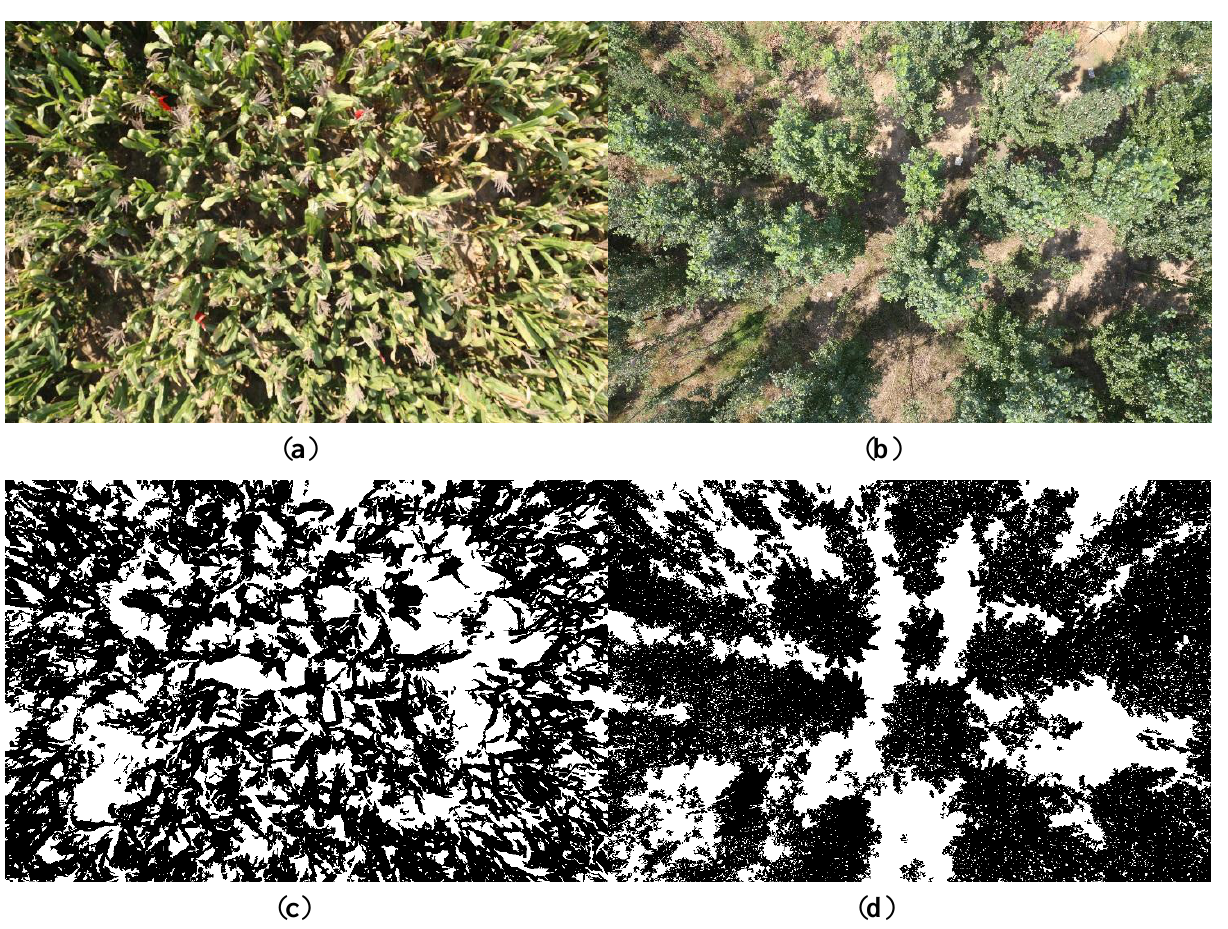
Figure 10. The actual downward-looking digital images acquired under clear-sky conditions for a corn region on 20 September 2014 ( a ) and for an aspen region on 27 July 2014 ( b ) at the Huailai site. Both of the two images were acquired at nadir view ( θ classification results of sunlit foliage (in black) and background (in white) by the automated LAB2 algorithm for the corn region and the aspen region are shown in ( c , d ),